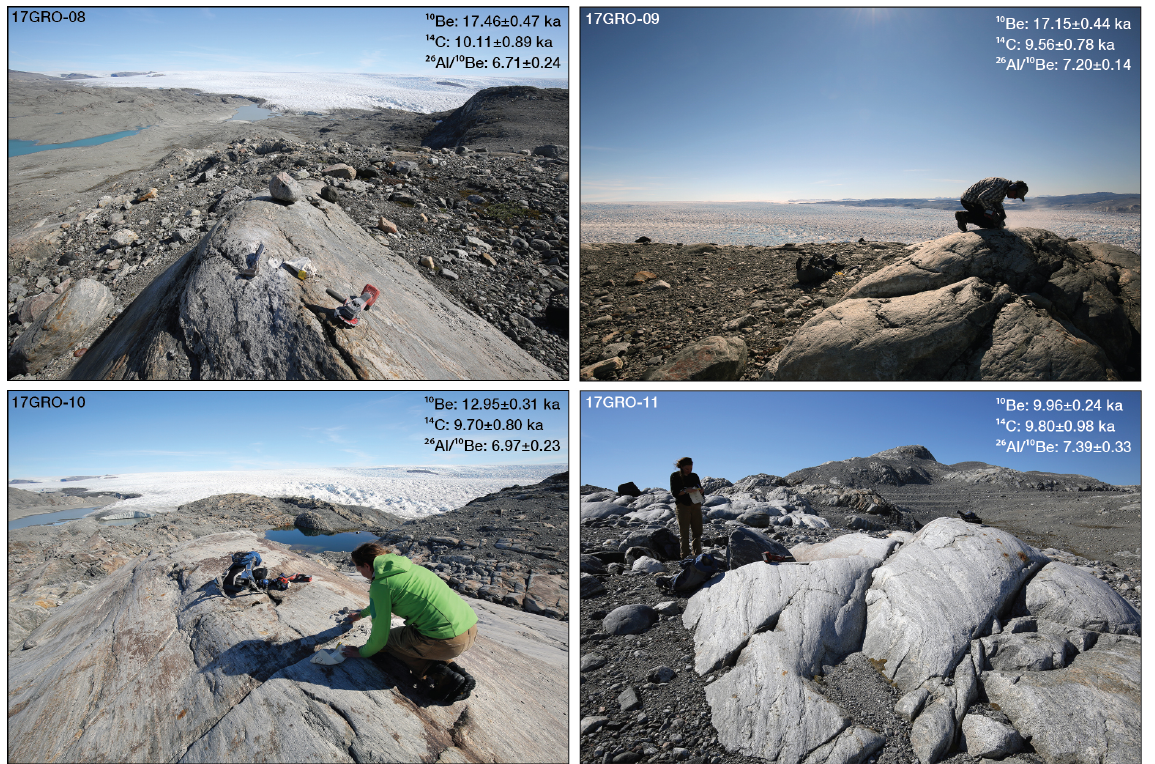
Figure 11. Sampled bedrock surfaces located between the historical maximum extent of the GrIS and the modern ice margin on the north- eastern side of